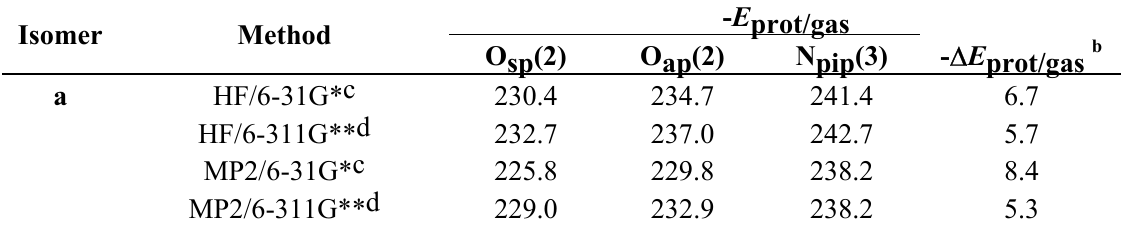
Table 3. Energies of protonation ( E prot/gas)a calculated for heteroatoms in model compounds of cytisine: N-methyl-2-pyridone ( 2 ) and piperidine ( 3 ) in the gas phase using eq